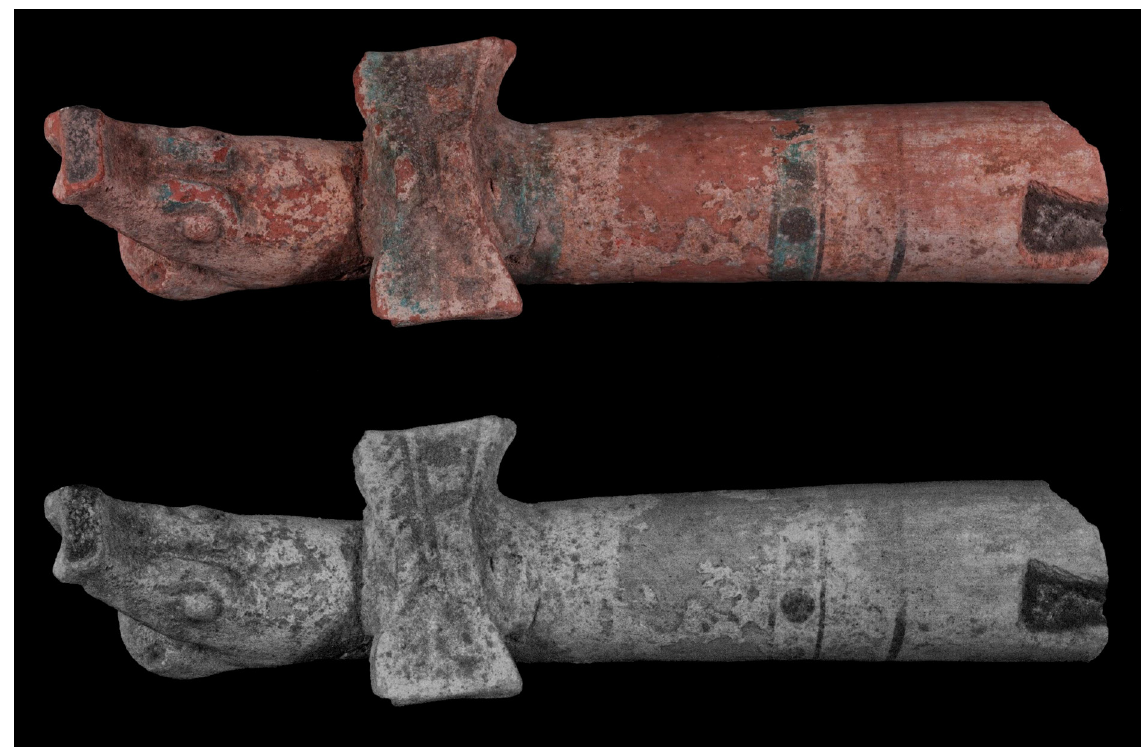
Fig. 4.8. Pre-Columbian handle of an incense shovel from the Royal Museum of Art and History (RMAH) collections, on top in white light, at bottom in infrared. The infrared image only displays carbon-based pigment in black, the other pigments used are transparent to infrared.